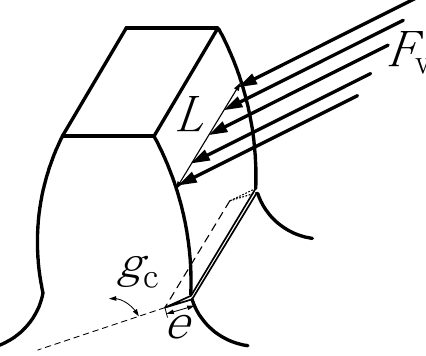
Figure 6. Meshing root crack model.